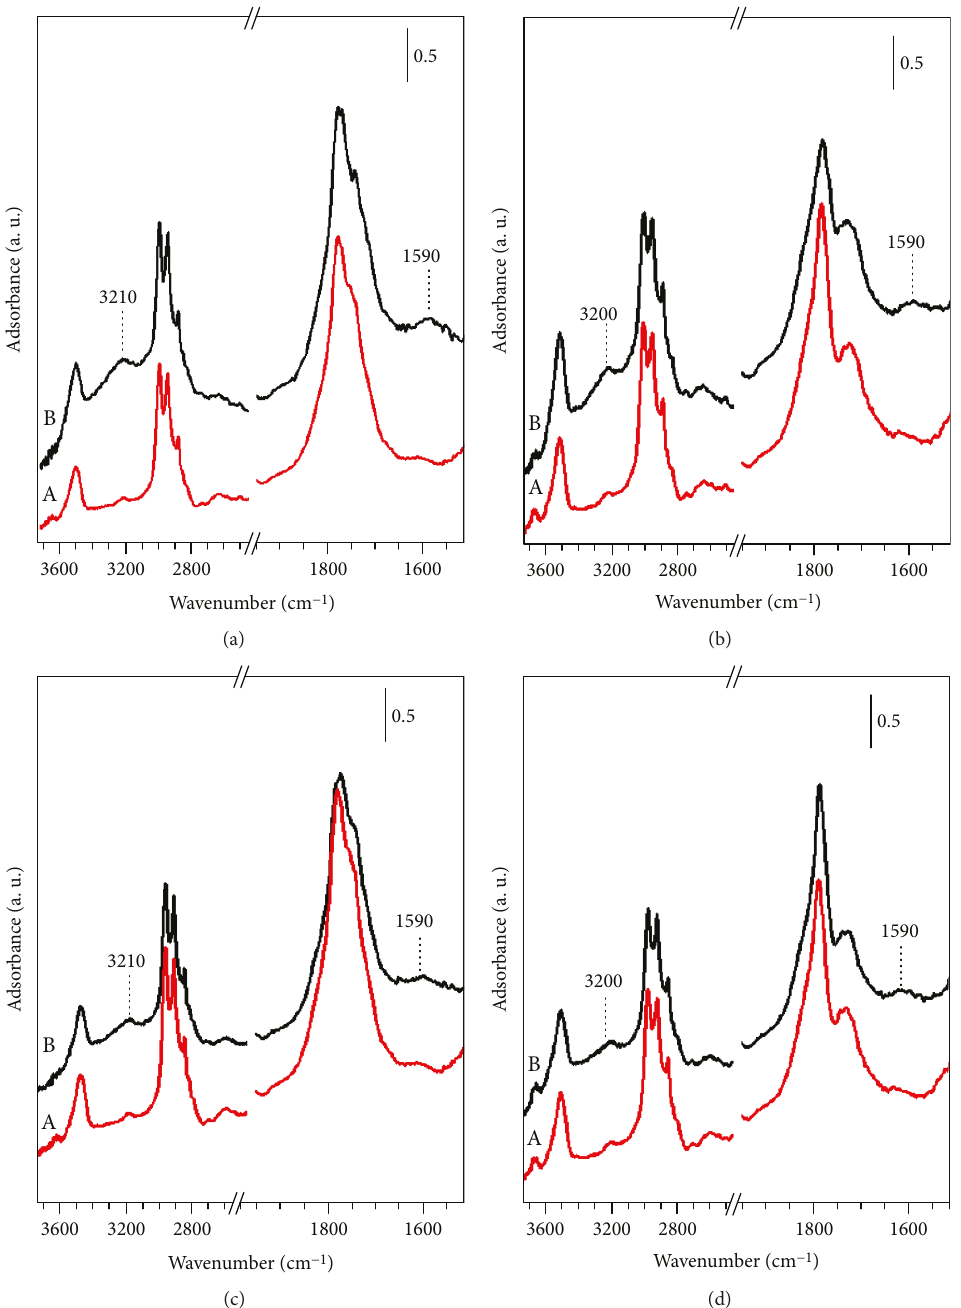
Figure 6: DR-FTIR spectra in the range 3700 – 1600 cm − 1 of (a) spectra of sample in vacuum; (b) spectra of sample in vacuum after the interaction with NH . (a, b) Spectra of samples functionalized with – COOH by continuous plasma (front and back, respectively). (c, d) 3(g) Samples functionalized with – COOH by pulsed plasma (front and back,